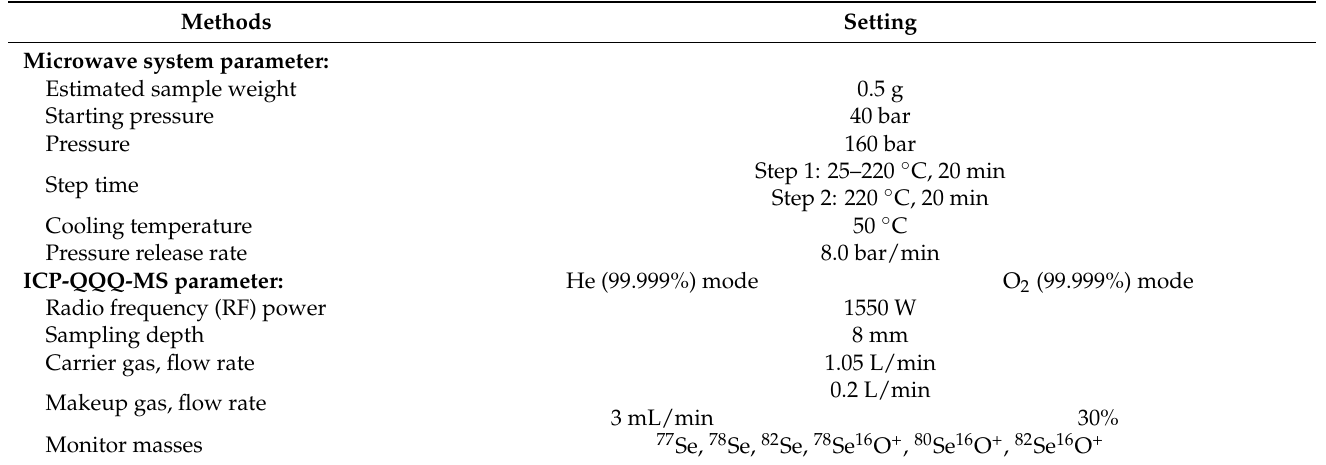
Table 2. Parameters used for digestion and analysis of total selenium